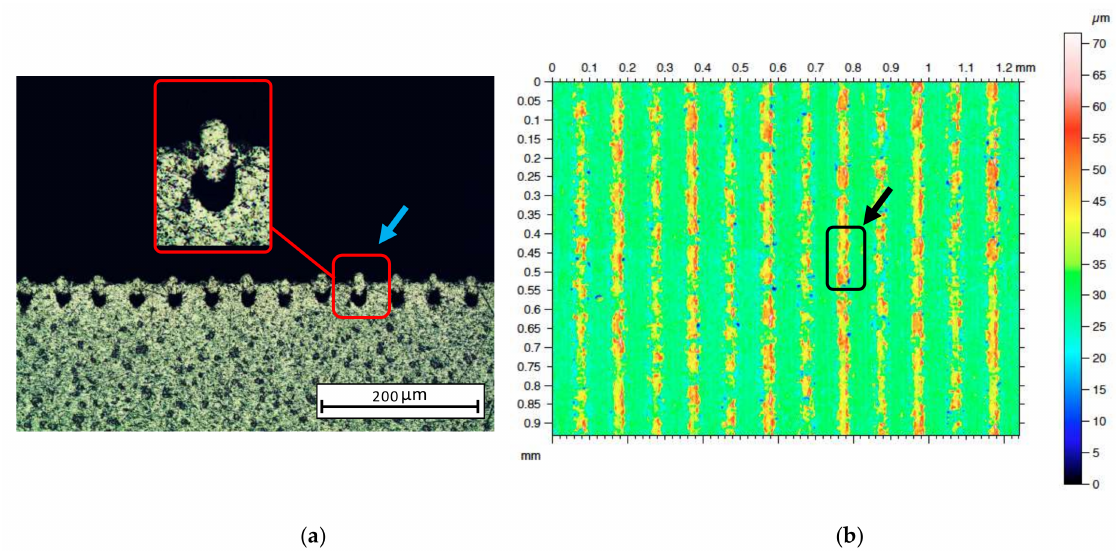
Figure 6. Solidification of melted metal over the textured grooves ( V s = 150 mm/s). ( a ) Groove geometry; ( b ) Textured tracks